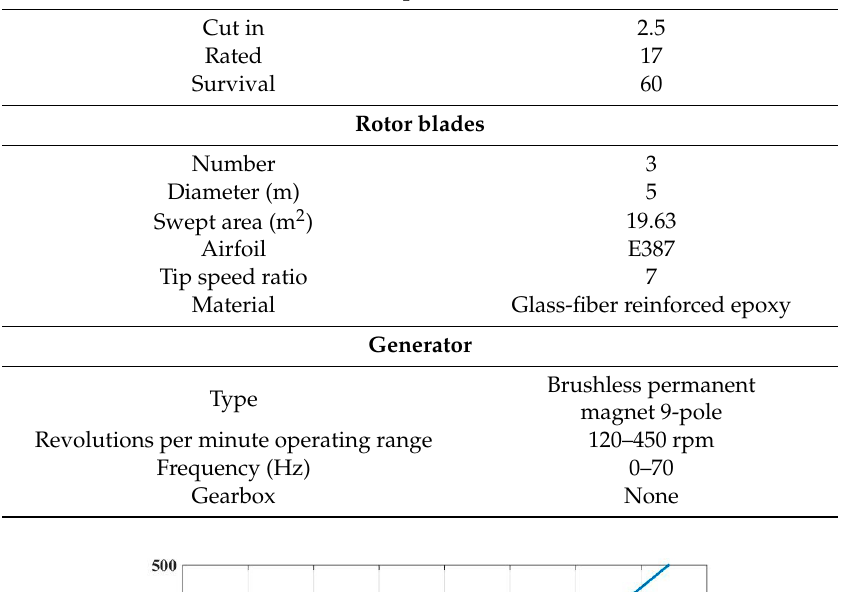
Table 1. Main parameters of the wind turbine [30].